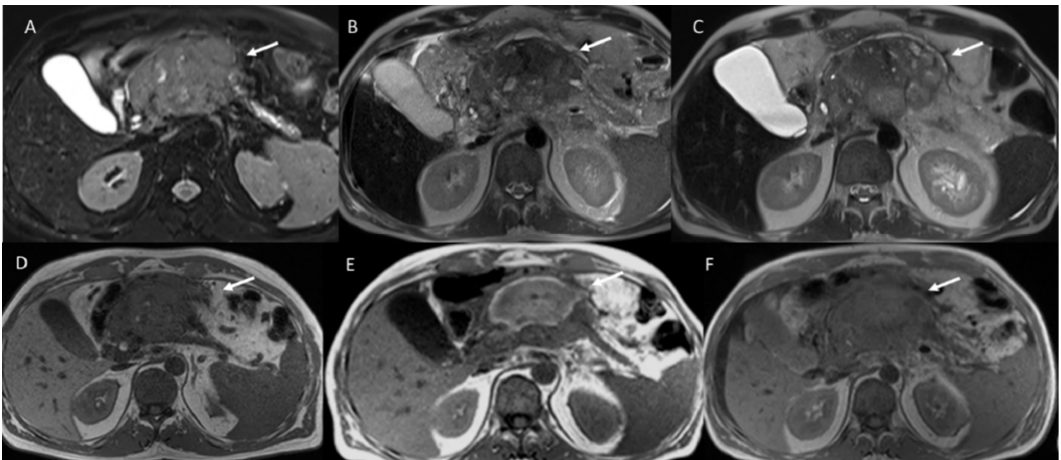
Figure 3. Pancreatic cancer treated with ECT. Pre-treatment, the lesion is hyperintense on T2 weighted sequence ( A ) and hypointense on T1 weighted sequence ( D ). After 1 week, the treated lesion is heterogeneously hyperintense on T1 weighted image ( E ) and heterogeneous hypointense on T2 weighted image ( B ) because of necrosis, hemorrhagic products and dehydration. After 1 month, the imaging appearances change as the blood products evolve and become more homogeneous over time on T2 weighted image ( C ) and T1 weighted image ( F ).